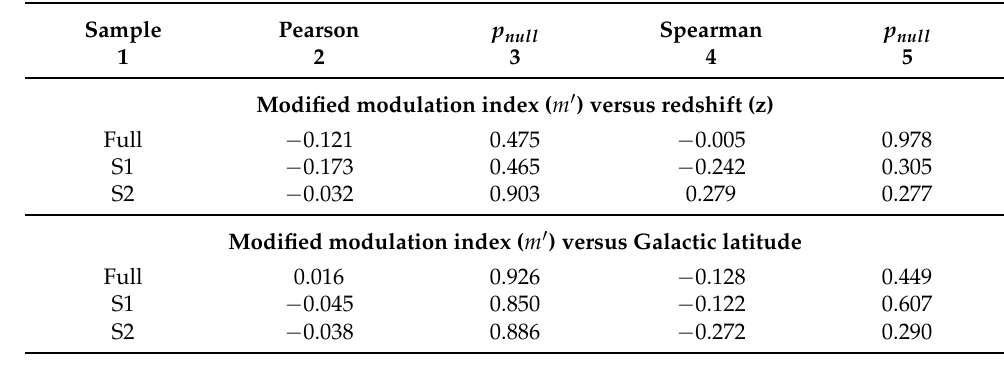
0.005 0.978 − 0.242 0.305 −